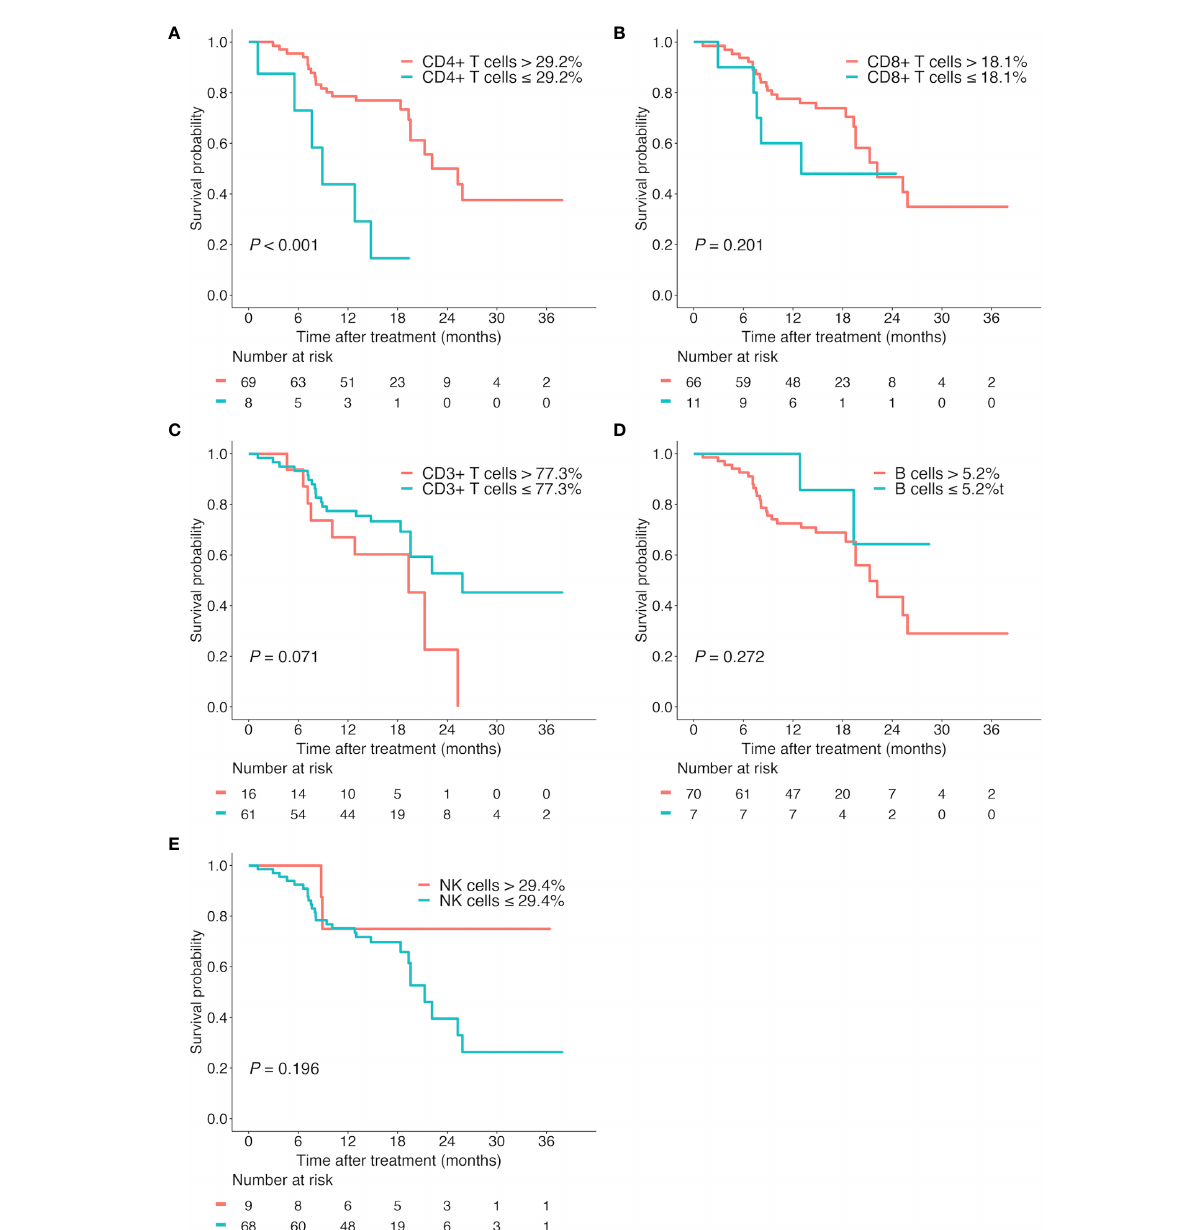
FIGURE 4 Kaplan-Meier survival curves according to different lymphocyte subsets. Overall survival according to the proportion of CD4+ T cells (A) , CD8+ T cells (B) , CD3+ T cells (C) , B cells (D) , and NK cells (E)